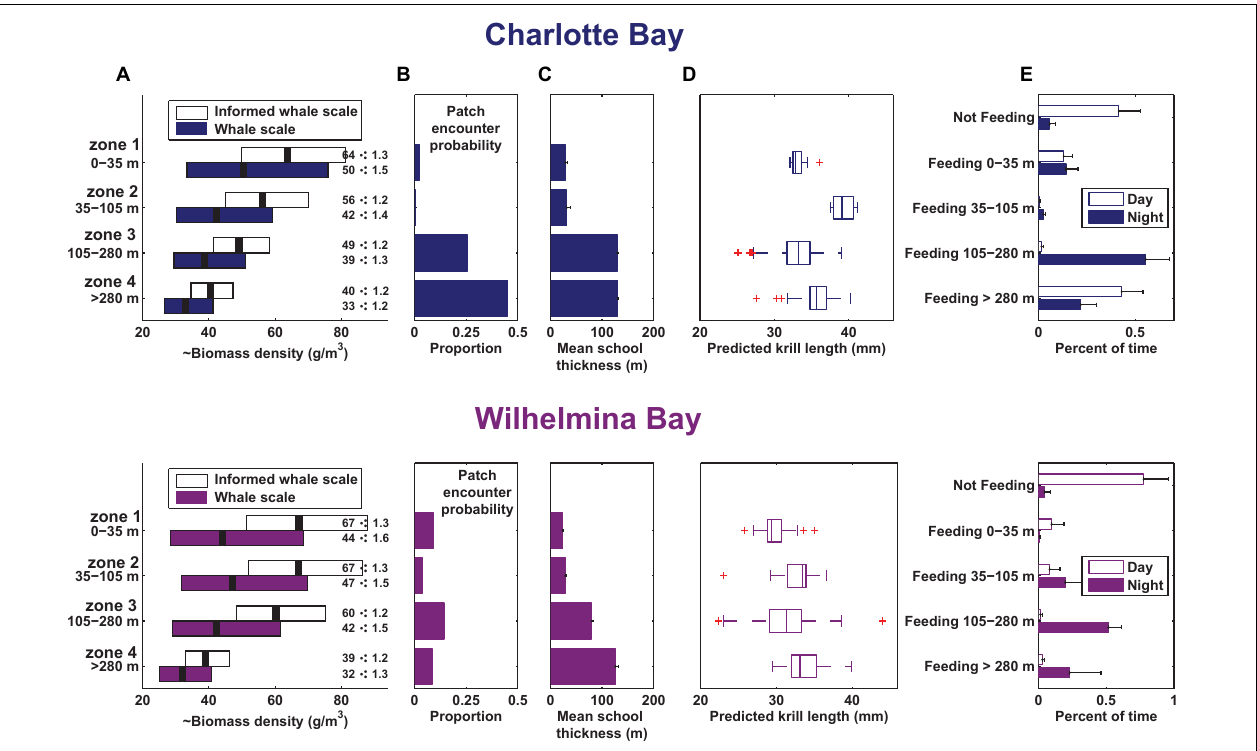
FIGURE 6 | Summary of prey data and foraging behavior by depth zone in each bay. (A) Geometric mean and geometric standard deviation of biomass by depth zone (measured at the whale scale, where · : means multiply or divide). (B) Proportion of columns of dive-sized analytical cells that contained a cell in the indicated zone with krill data above the threshold for inclusion (see section “Materials and Methods”), standardized for the height of the column. (C) Mean school thickness of patches in dive-sized cells in each depth zone. (D) Estimated krill length from 120 to 38 kHz dB differencing in each gulp-sized cell in the depth zone. Boxes are min, first quartile, median, third quartile, max data points, excluding outliers. (E) Mean percent of time spent by the tagged whales in each behavior. Error bars in panels (B,C,E) are standard